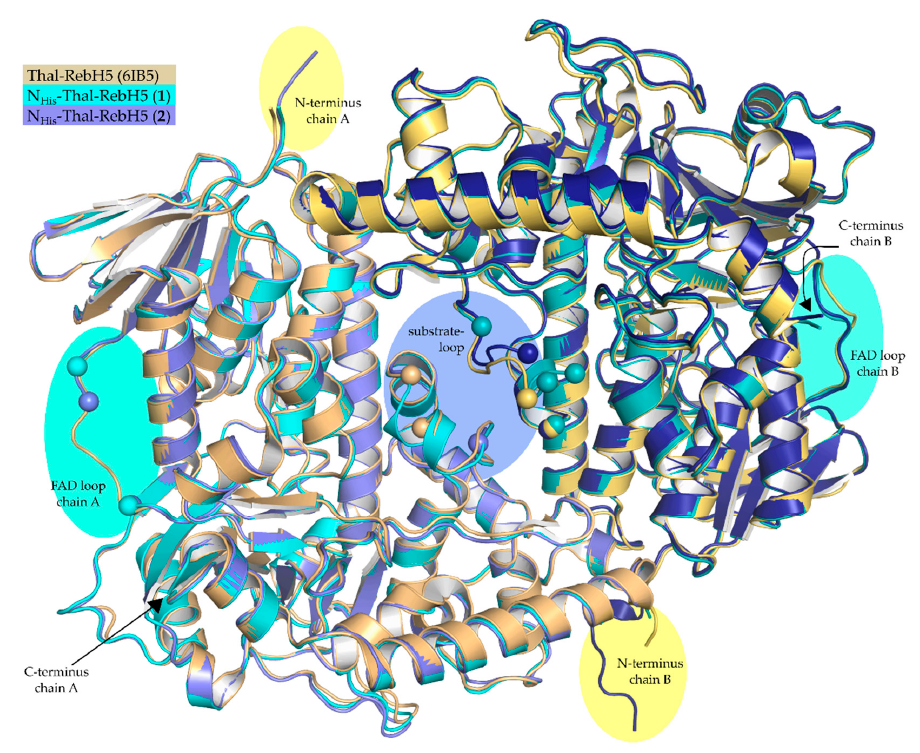
Figure 3. Alignment of Thal-RebH5 (yellow / orange), N His -Thal-RebH5 ( 1 ) (cyan) and ( 2 ) (light blue / blue). Overall, all three structures are very similar, only di ff ering in loop sections and length of the N-terminus (highlighted in yellow). Disordered regions like the FAD loop (highlighted in turquoise) or substrate-binding loop (highlighted in violet) are marked structure-specific with a sphere of the last and next modeled C α - atom.